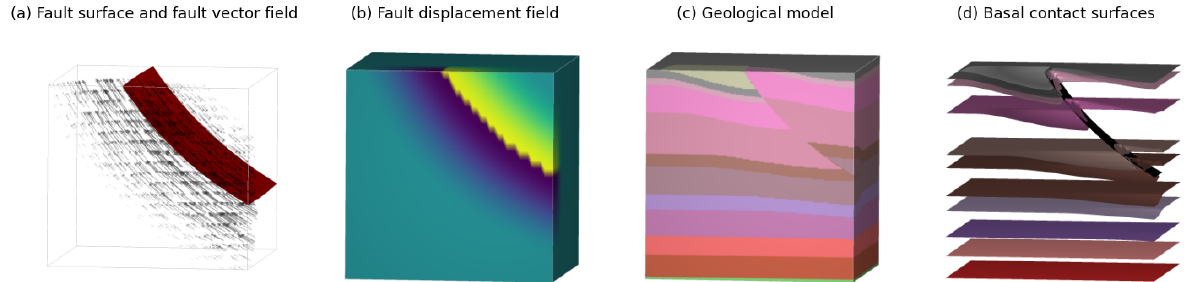
Figure 8. Finite fault applied to flat-lying stratigraphy. (a) Fault displacement vectors and isosurface of fault surface scalar field. (b) Scalar field of fault displacement. (c) Geological model showing unit distributions for stratigraphy. (d) Surfaces of